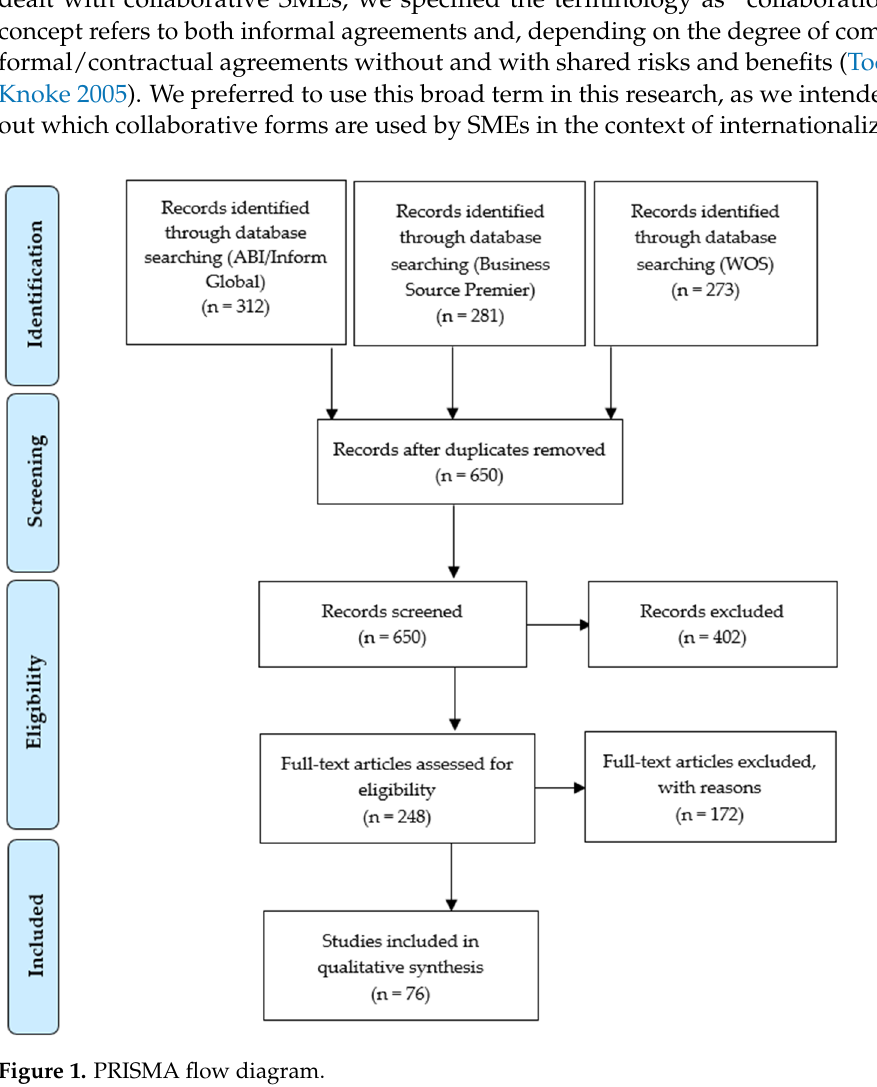
Table 1. Inclusion and exclusion criteria assumed for the literature review.